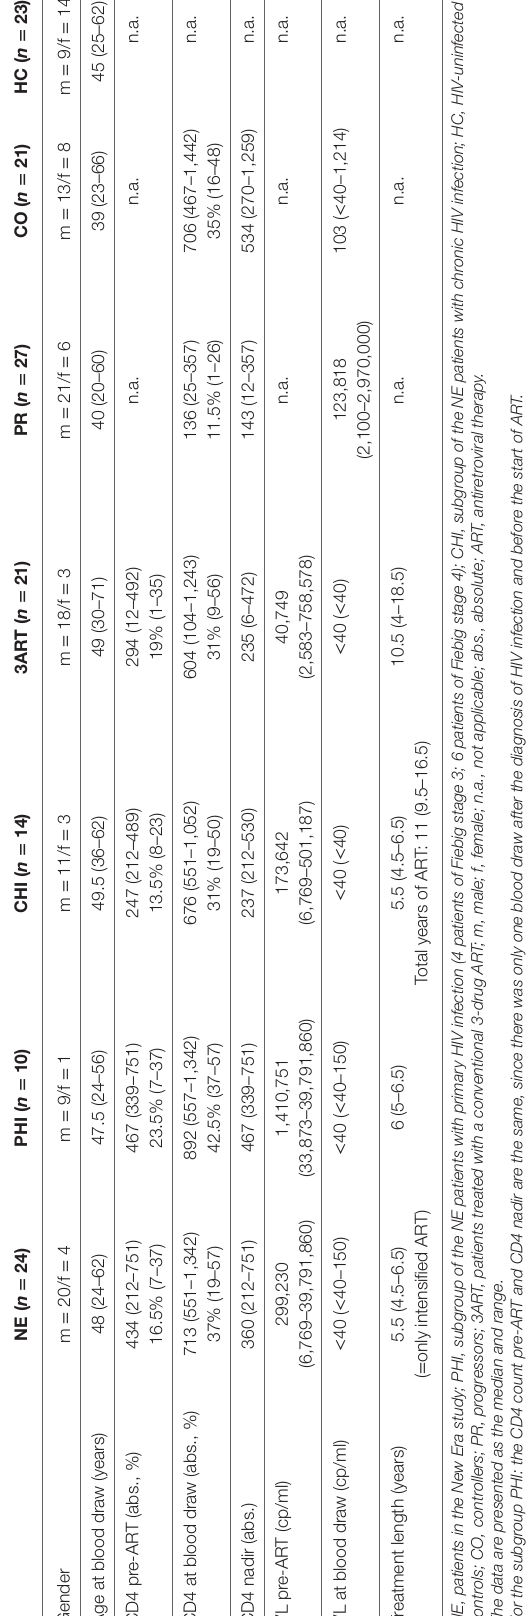
Peripheral Blood